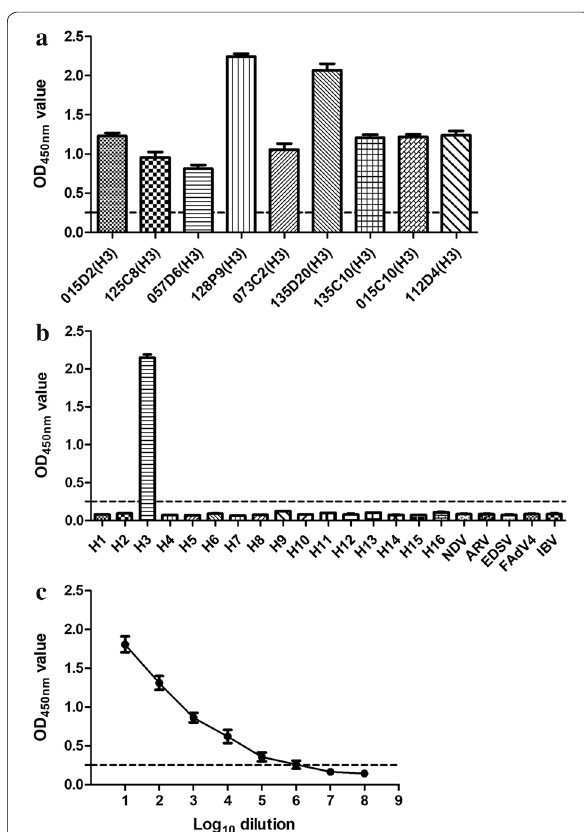
Fig. 3 Specificity and sensitivity of the sandwich ELISA. a Different H3 isolates were tested and shown to be positive. b Other HA subtypes of AIV, NDV, ARV, EDSV, FAdV4 and IBV were tested and shown to be negative. c Sensitivity of the sandwich ELISA for H3 virus detection. Dotted line indicates the cutoff value